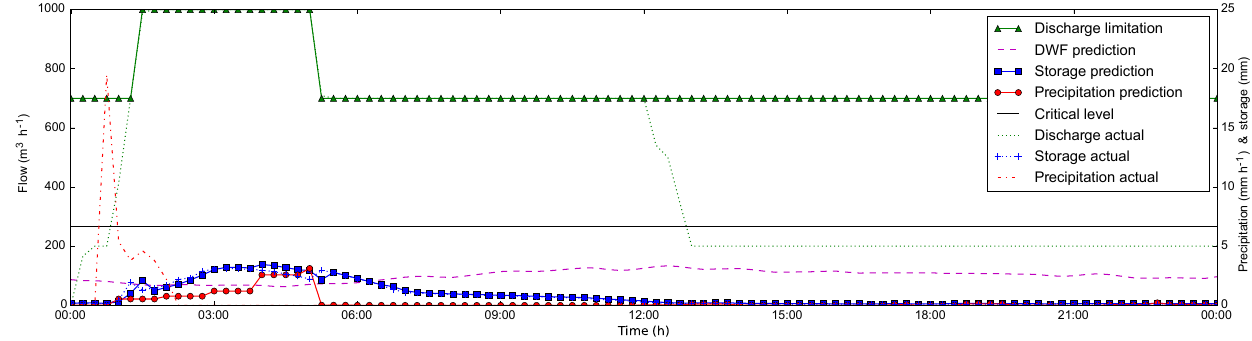
Figure 4. Example of bypass reduction with a conservative approach at WWTP Bennekom for the event of 16